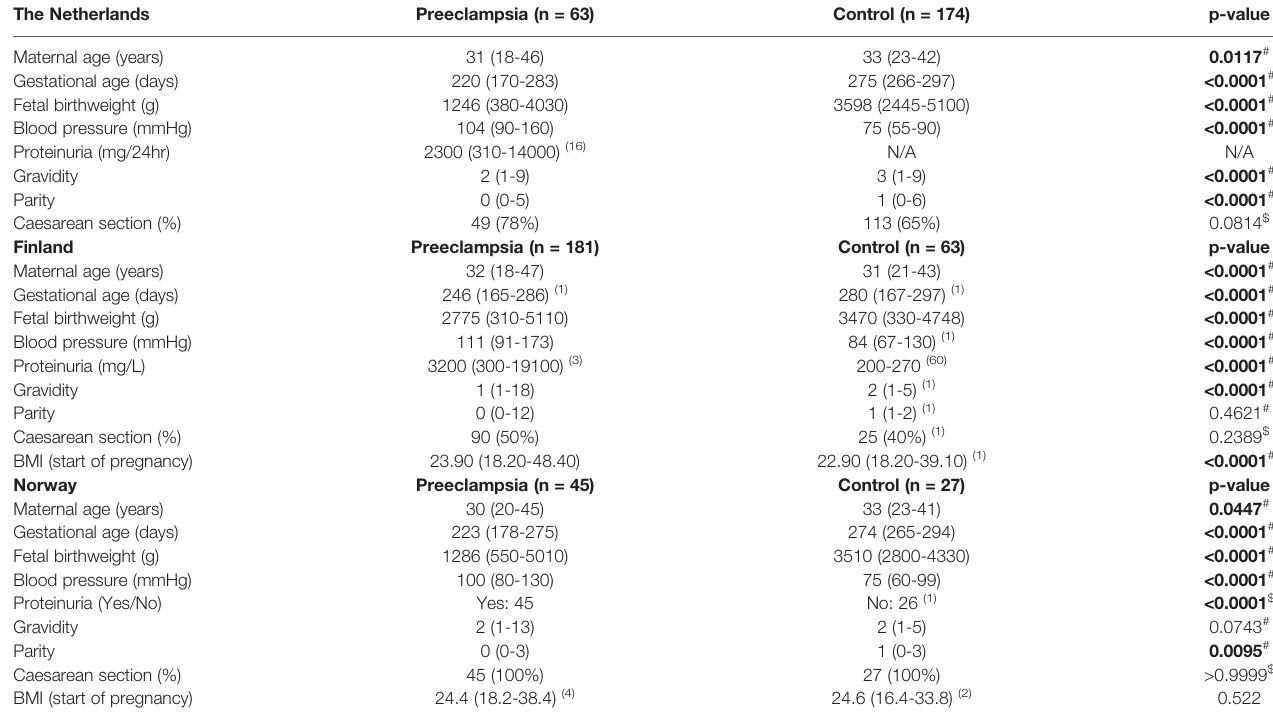
TABLE 1 | Clinical characteristics of the included